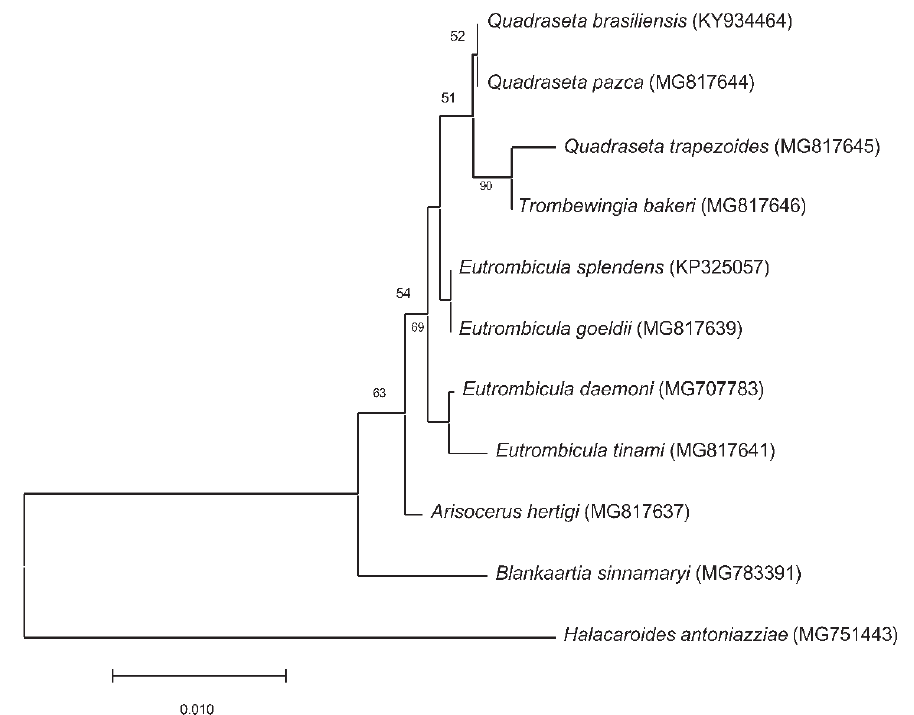
Figure 5. Neighbor-Joining tree of small subunit rRNA sequences of chiggers collected from North and South American countries. The chigger small subunit rRNA sequences data were downloaded from GenBank only from peer-reviewed journal publications. The Halacaroides antoniazziae (MG751443) was used as an outgroup. The percentage of replicate trees in which the associated taxa clustered together in the bootstrap test (1000 replicates) are shown below the branches. The tree was drawn to scale, with branch lengths in the same units as those of the evolutionary distances used to infer the phylogenetic tree. The evolutionary distances were computed using the Kimura 2-parameter method and are in the units of the number of base substitutions per site. This analysis involved 10 nucleotide sequences. All positions containing gaps and missing data were eliminated (complete deletion option). There were a total of 403 positions in the final dataset. Evolutionary analyses were conducted in MEGA11.